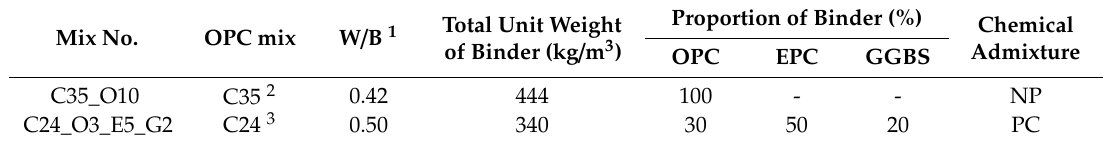
Table 3. Binder type and proportions of concrete.